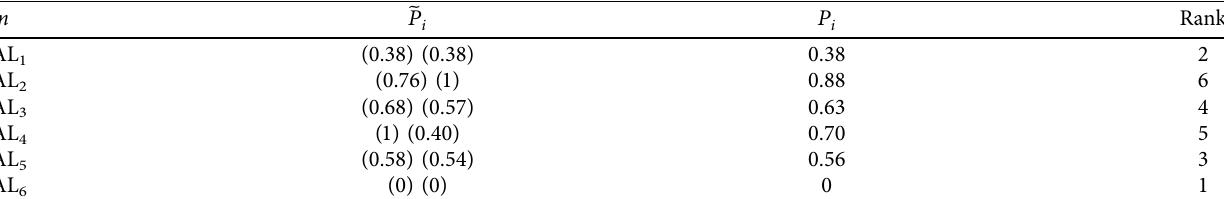
Table 14: Te rating of P i and rank of each alternative.